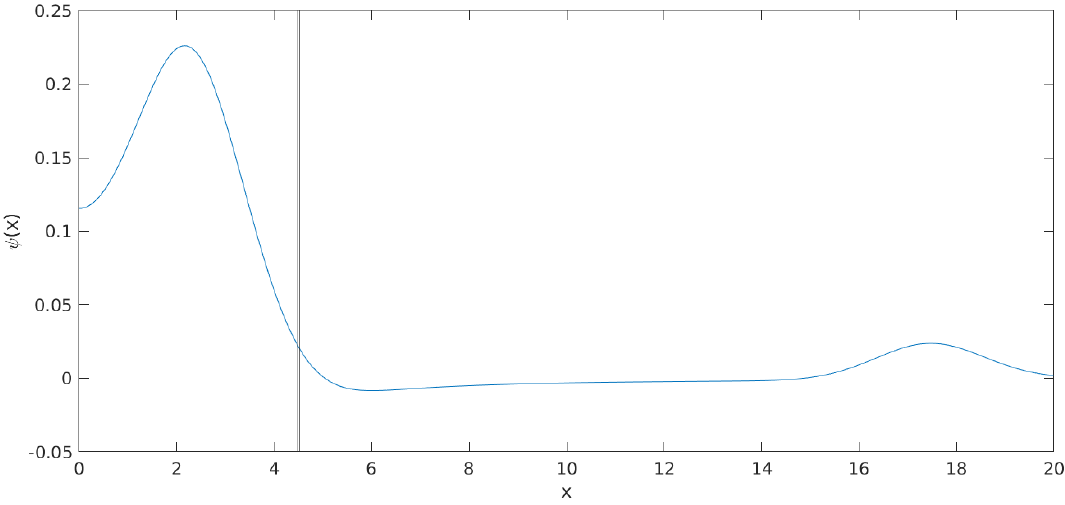
Figure 3: A scalar profile after the large field movement has just commenced. The vertical line(s) denote(s) the location of the apparent